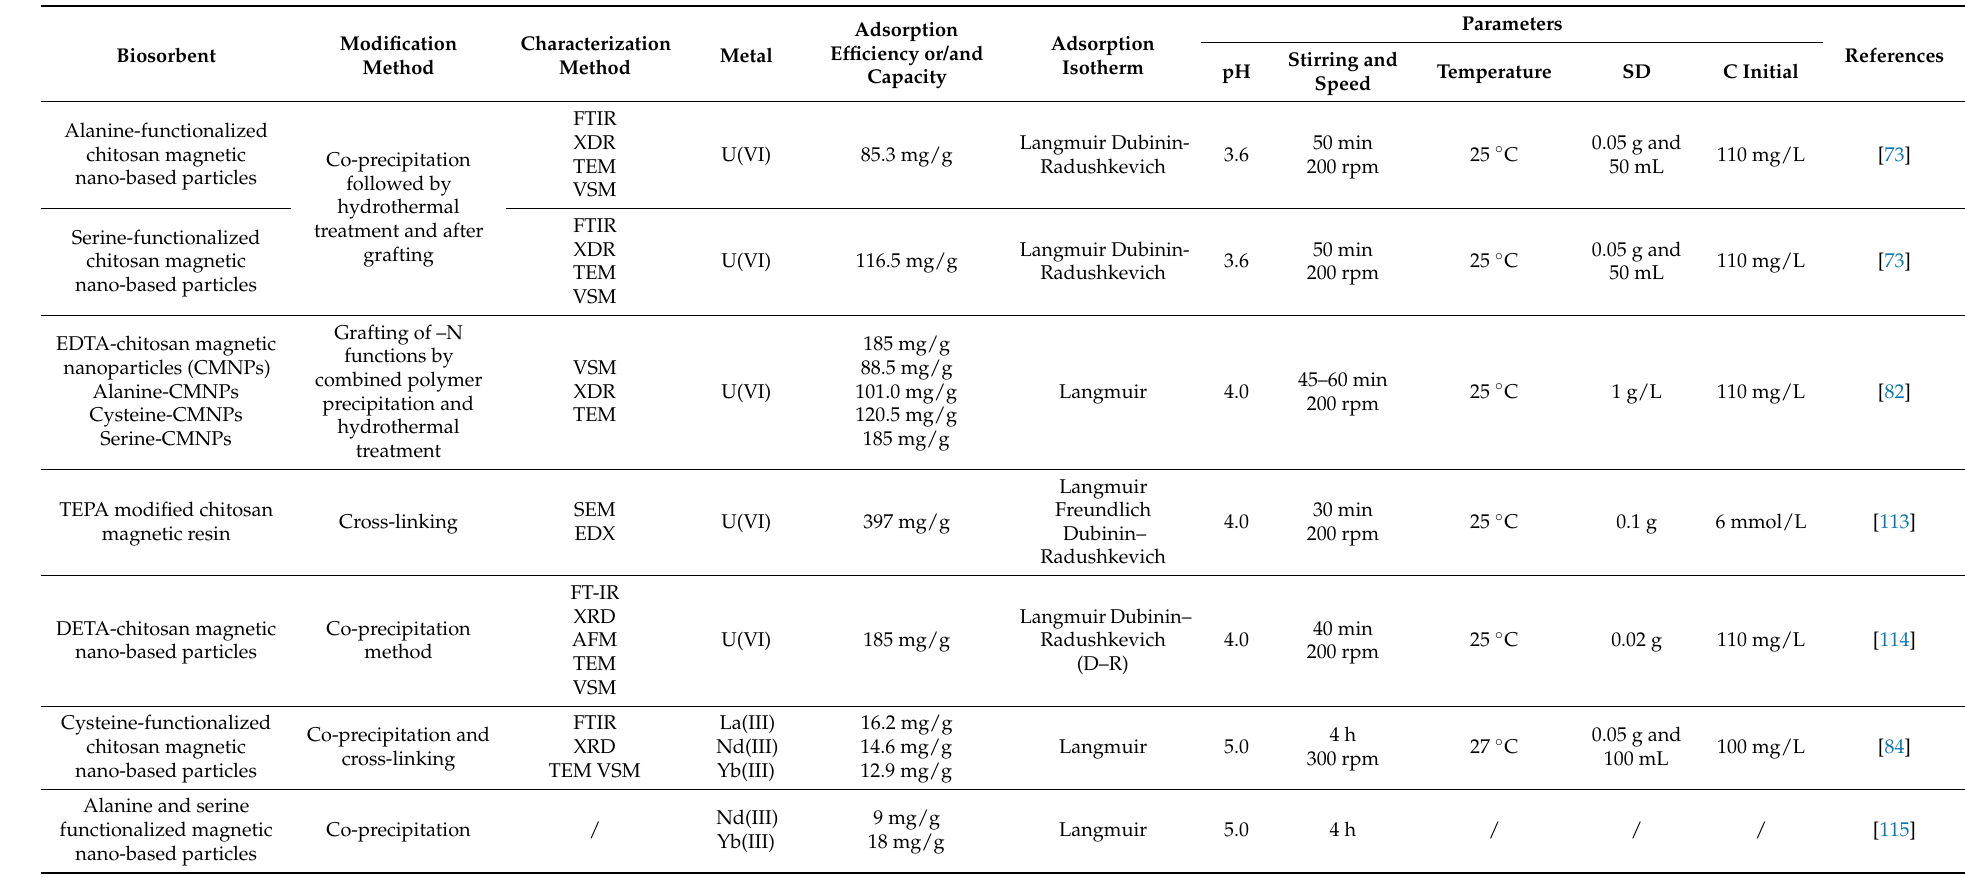
Table 4. Chitosan-based nanomaterials for uranium and rare earth metals